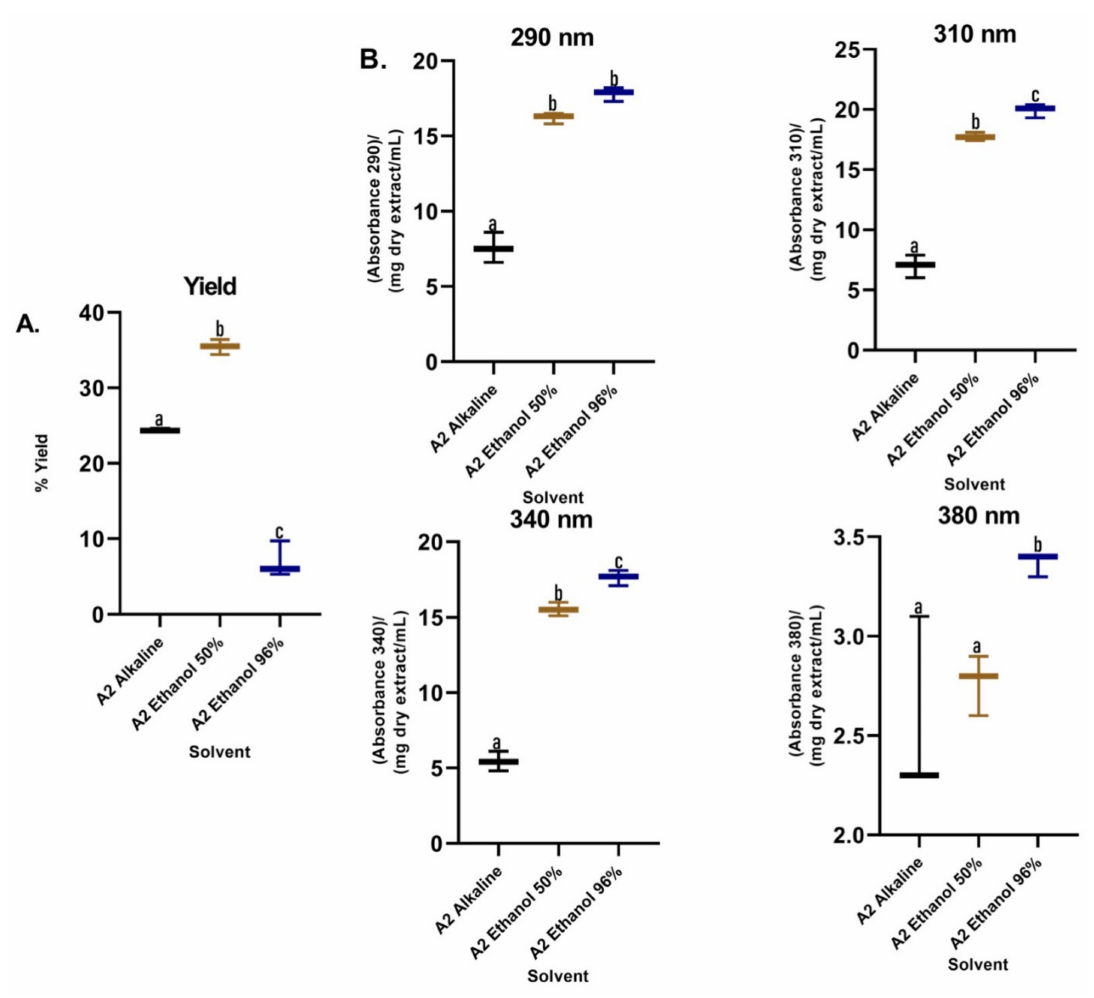
Figure 5. ( A ) Yields of B. antioquensis sequential extractions in different solvents. ( B ) Relative absorption coefficients (RAC) of extracts of B. antioquensis (Assay 2). Values with different letters are significantly different ( p <